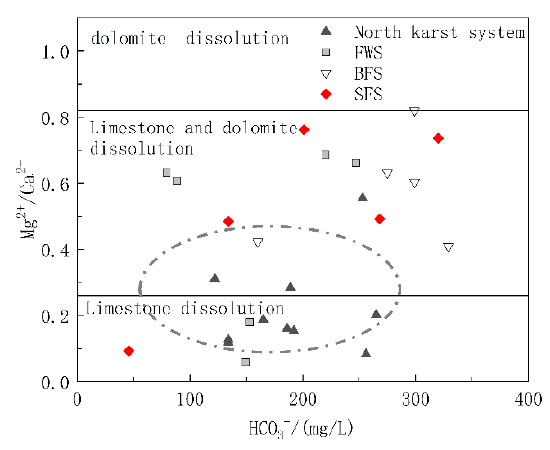
Figure 6. Relationship of Mg 2+ /Ca 2+ and HCO 3− in underground water samples.